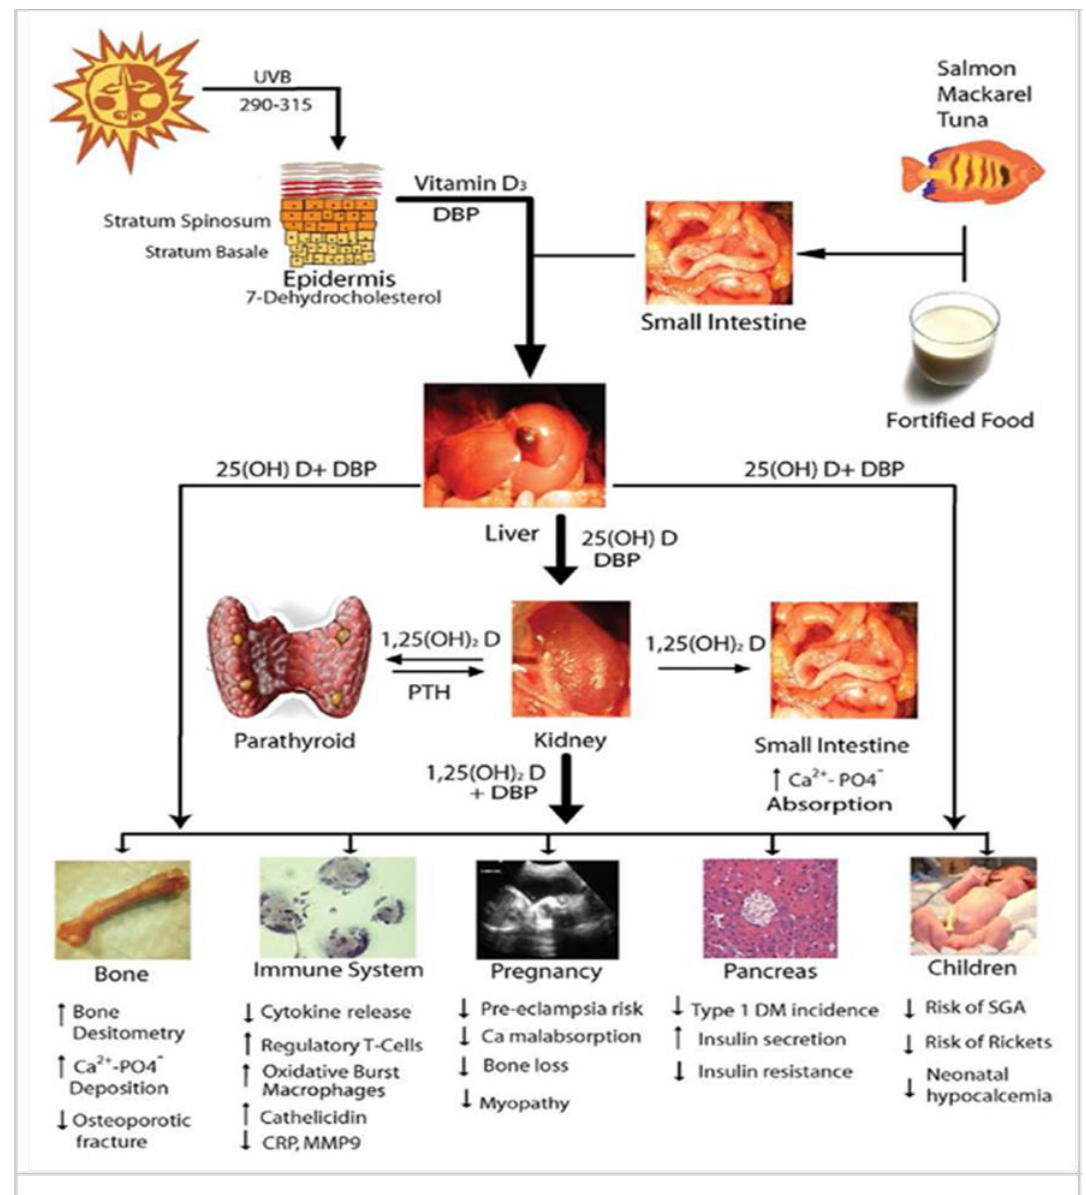
Figure 1. Vitamin D metabolism and its action in the body. Source of Figure 1: Mulligan, M.L.; Felton, S.K.; Riek, A.E.; Bernal - Mizrachi, C. Implications of vitamin D deficiency in pregnancy and